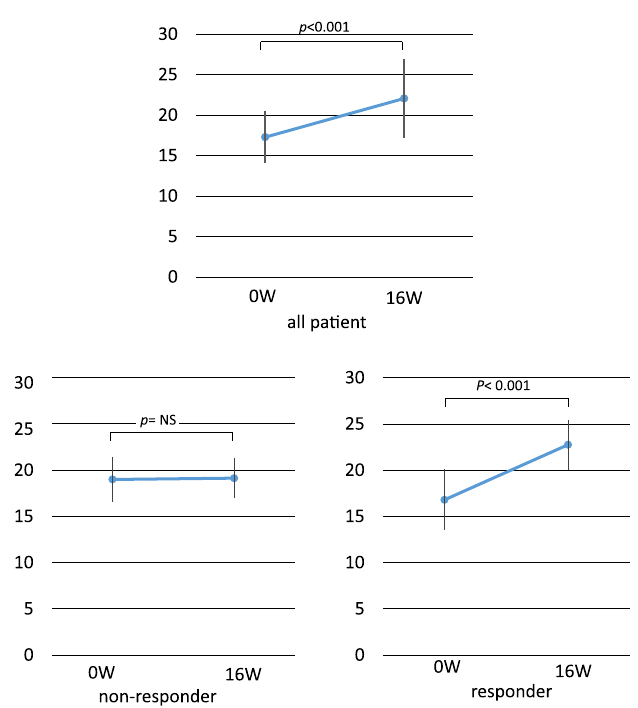
Figure 2 Comparison of ACT between 0 W and 16 W